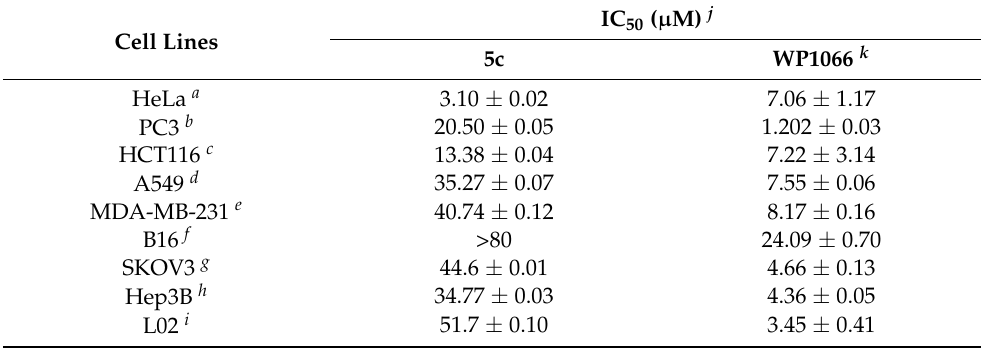
Table 2. Anti-proliferative activities of 5c against various cancer cell lines and normal cells. Cell